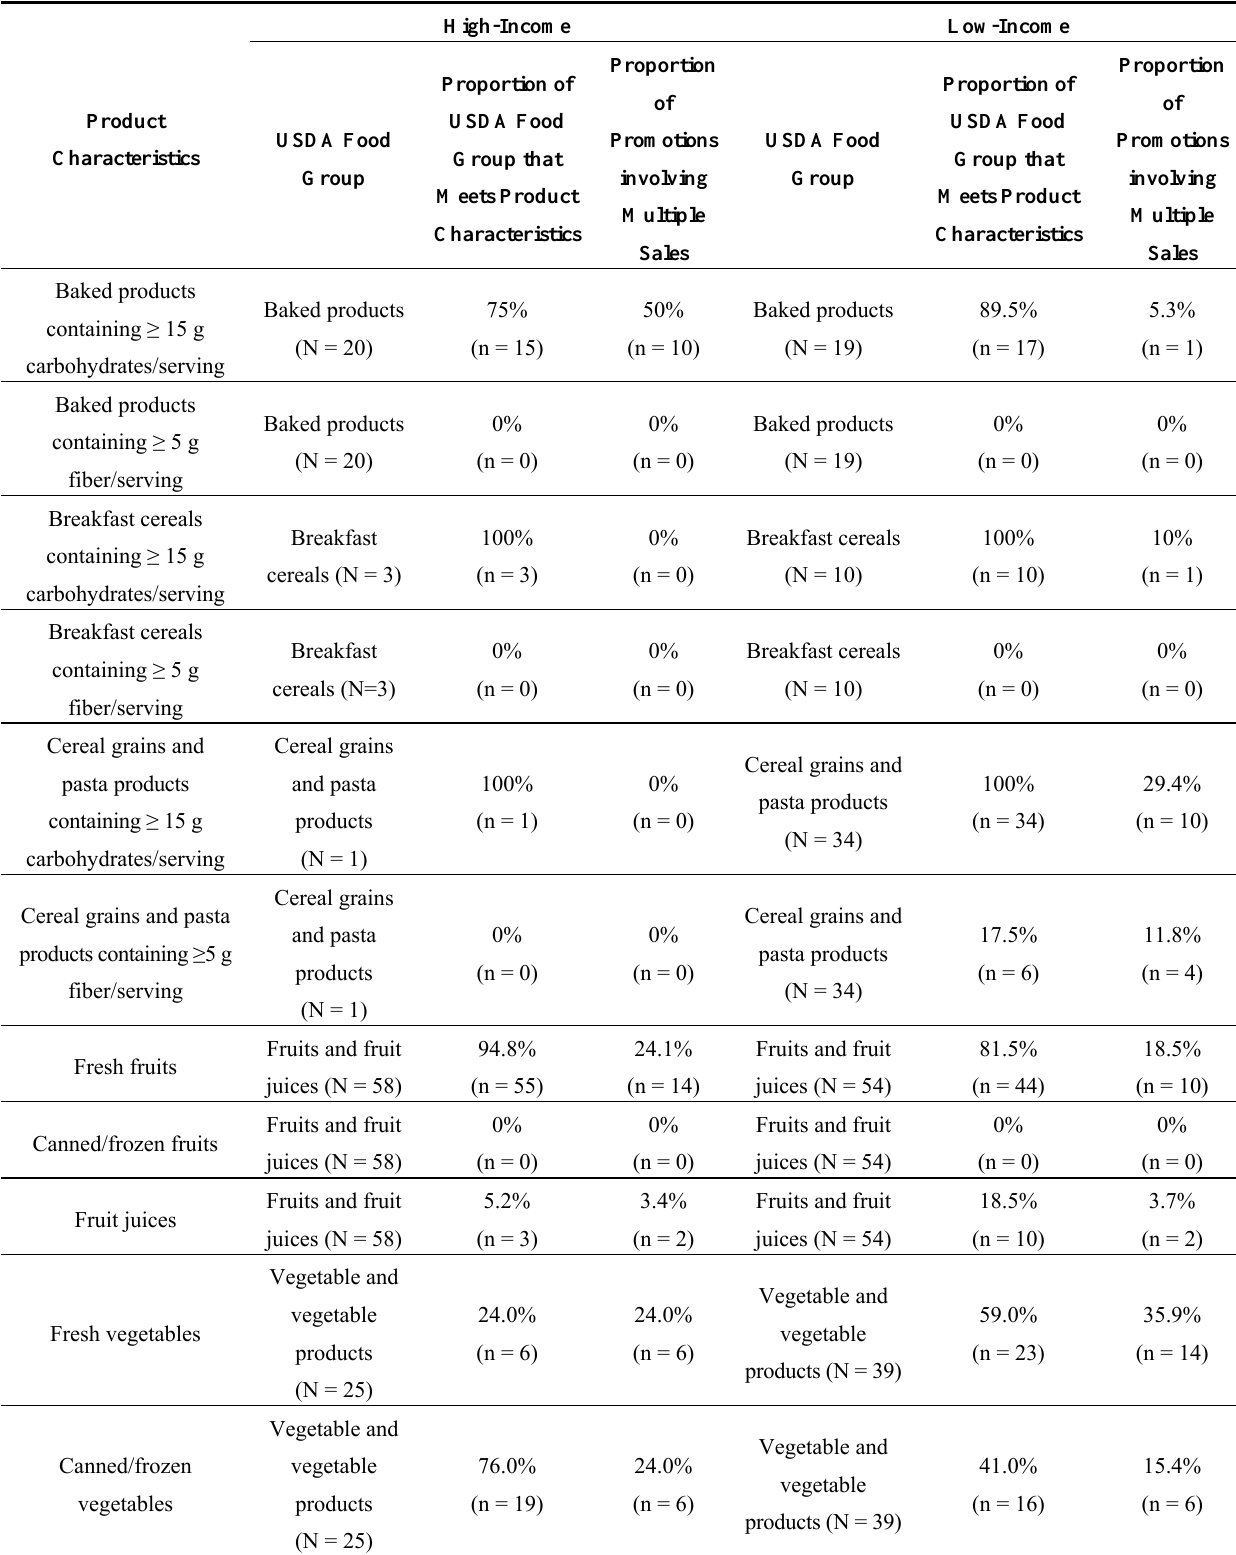
Table 2. Proportion of food products offered with promotions involving multiple sales: Low- versus High-income grocery stores in New York